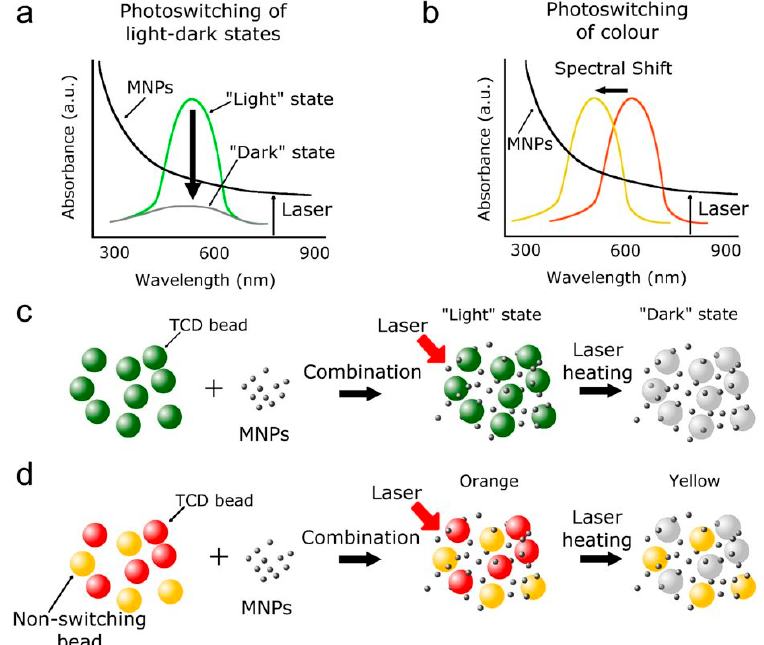
Figure 1. ( a ) Laser-induced temperature-dependent decrease of thermochromic dye (TCD) absorption (“light” to “dark” state transition) during laser heating of embedded magnetic NPs (MNPs). ( b ) Laser-induced temperature-dependent shift in the TCD absorption maximum (blue-shift color). ( c ) Schematic of switching from “light” to “dark” state in monocolor TCD-NP probe. ( d ) Schematic of switching color state in a two color TCD-NP probe. Reproduced with permission from